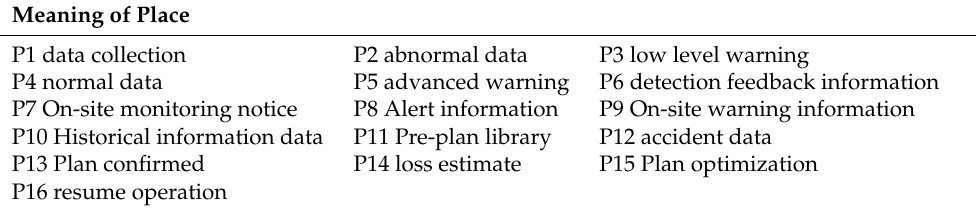
Table 3. The meaning of place in Petri